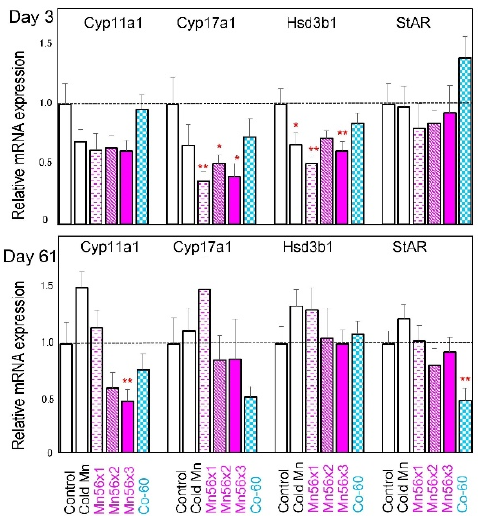
Figure 2. Relative mRNA expression levels of Cyp11a1, Cy17a1, Hsd3b1 and StAR genes in the testes of the rats on Day 3 (top) and Day 61 (bottom) after the exposure to 56 MnO 2 powder (Mn56×1, Mn56×2, and Mn56×3), Cold MnO 2 powder (Cold Mn), or 60 Co- γ exposure (Co-60). * p < 0.05 and ** p < 0.01 vs. control.